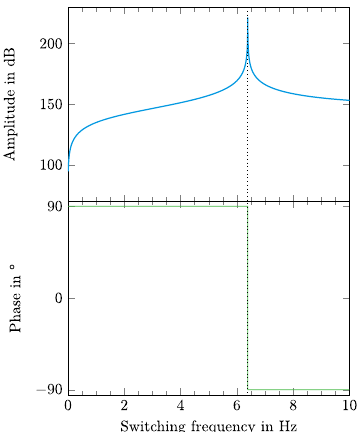
Figure 11. Frequency response of the amplitude and phase of the deflection w at the end of the fish fin from Figures 8 and 10, respectively. The resonance frequency of 6.385 Hz is marked.